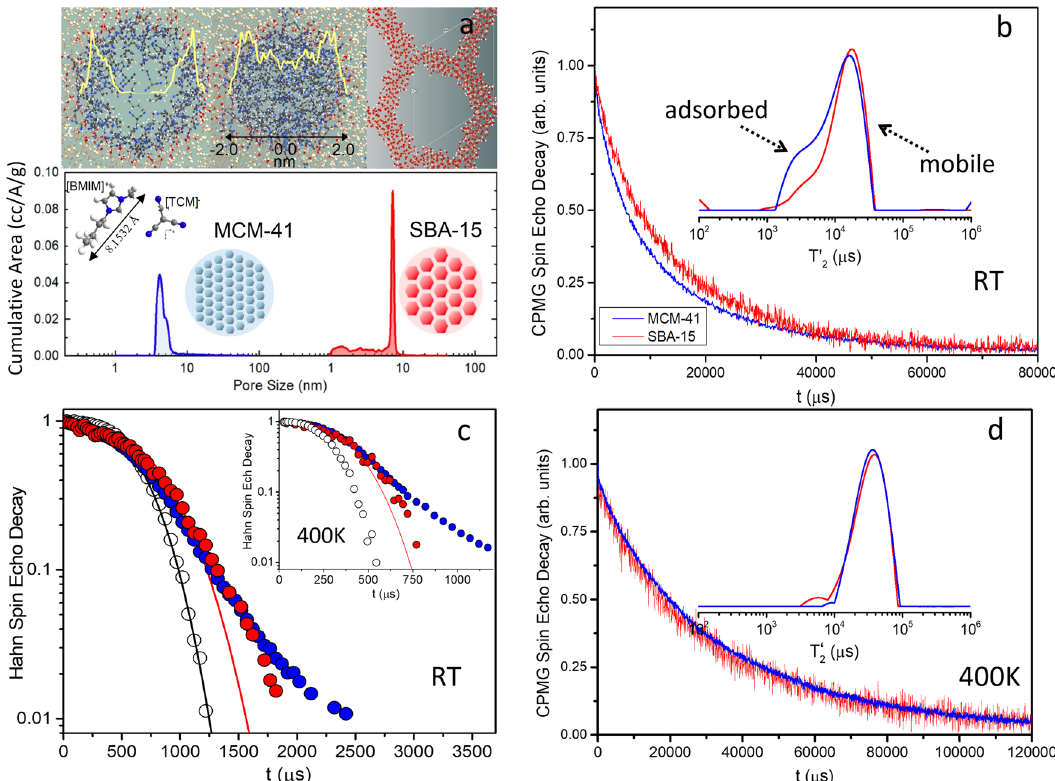
Fig. 1 Adsorbed and mobile [BMIM] + cations resolved with 1 H NMR T 0 distribution analysis. a Snapshots of MD simulations of [BMIM] + [TCM] − 2 inside MCM-41 at low and high RTIL concentration (blue: nitrogen, grey: carbon, white: hydrogen, yellow: silicon, red: oxygen). The yellow lines are the relevant radial RTIL density pro fi les. By increasing the RTIL concentration, the density appears to be radially modulated. The lower panel shows the liquid nitrogen porosimetry curves of MCM-41 (blue) and SBA-15 (red). b CPMG SEDs at RT of [BMIM ] + [TCM] − con fi ned into MCM-41 (blue line) and SBA-15 (red line). The inset shows the effective spin-spin relaxation time T 0 distribution by inverting the CPMG SEDs. c The Hahn SEDs of [BMIM] + [TCM] − in 2 bulk form (white circles), as well as inside MCM-41 (blue circles) and SBA-15 (red circles). Solid lines are fi ts to Eq. (1). The inset shows the relevant Hahn SEDs at 400 K. d CPMG SEDs at 400 K of [BMIM] + [TCM] − con fi ned into MCM-41 (blue line) and SBA-15 (red line). The inset shows the T 0 distribution 2 by inverting the